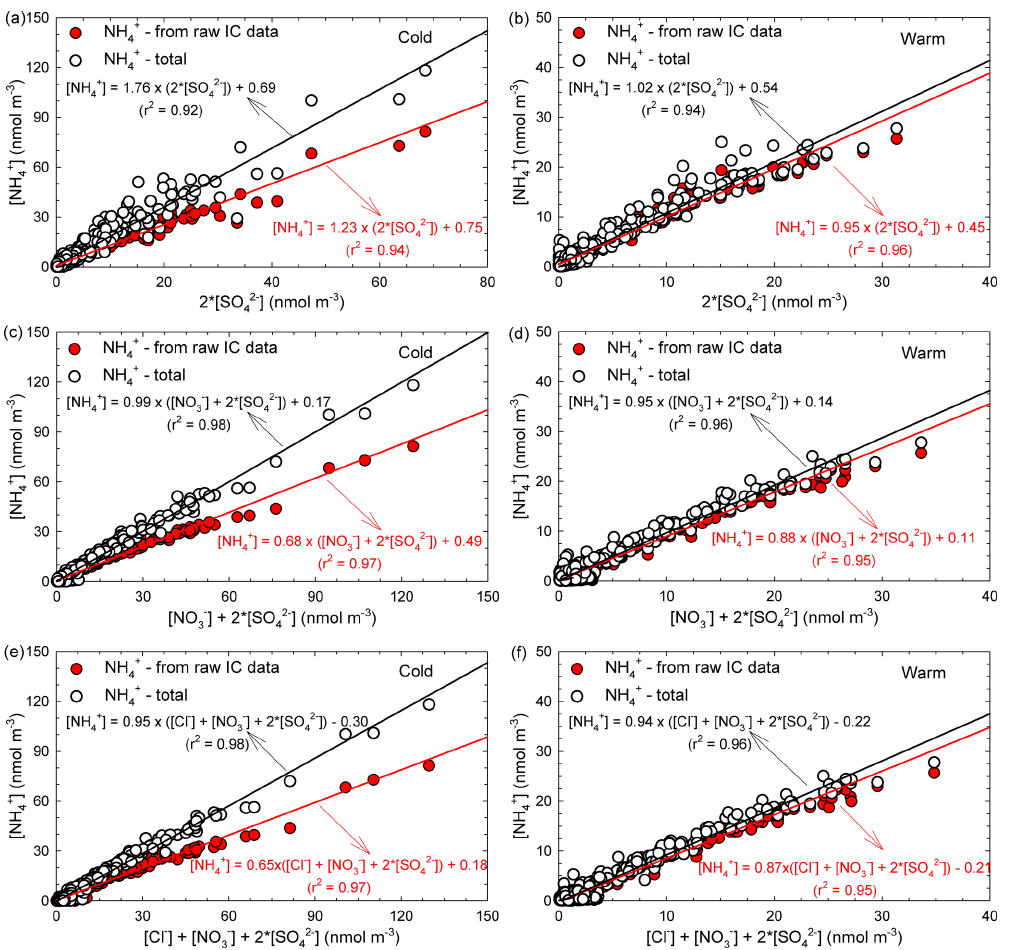
Figure 7. Regression analysis of the [NH + ([Cl − ] + [NO −